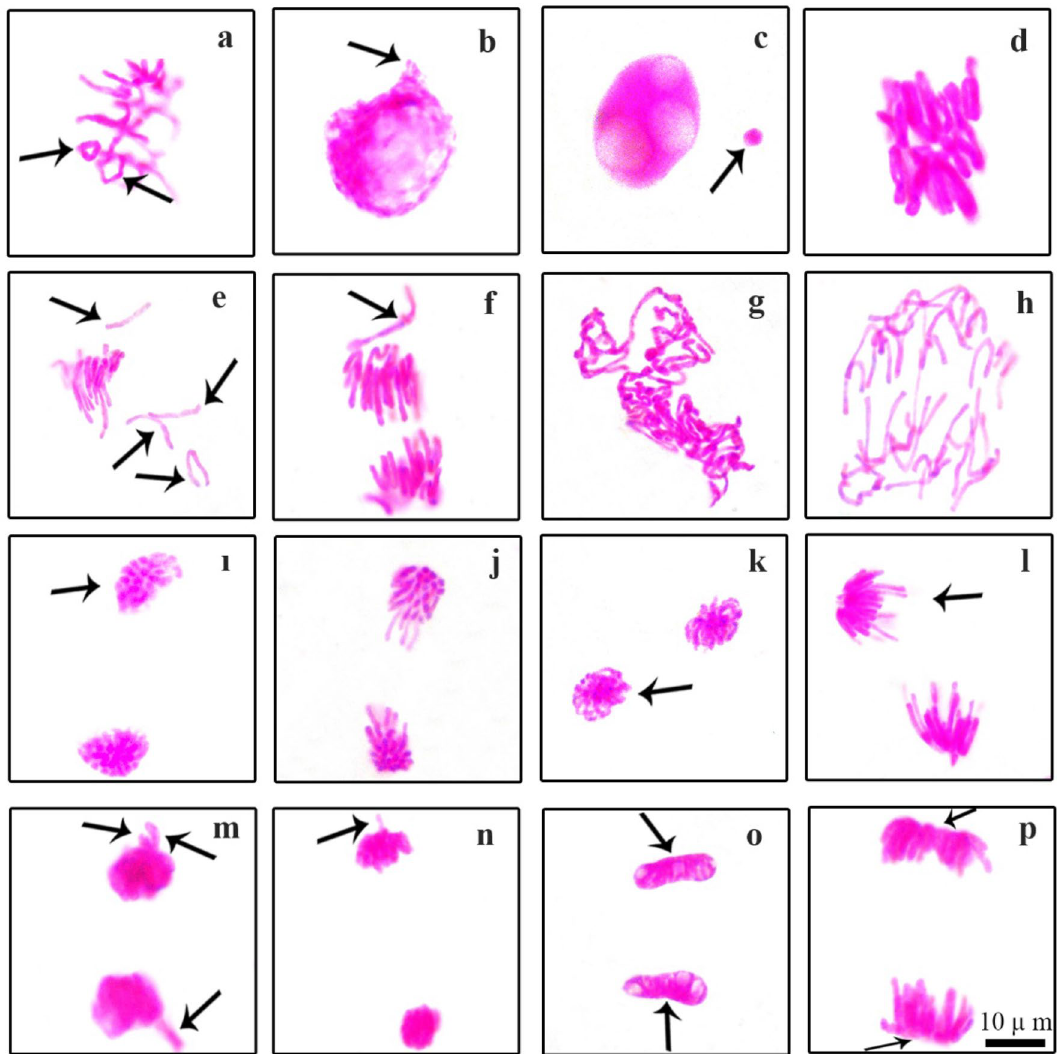
Figure 6. Chromosomal abnormalites in the root meristem cells of Allium cepa L. grown in 0.15 M NaCl and 0.01 µM COR + 0.15 M NaCl medium, ( a ) metaphase with chromosome encircleds = arrows, ( b ) nuclear budding = arrow, ( c ) trilobulated nucleus with micronucleus = arrow, ( d ) stickiness metaphase, ( e ) metaphase with chromosomal losses = arrows, ( f ) anaphase with chromosomal loss = arrow, ( g ) aberrant prophase, ( h ) aberrant anaphase, ( i ) anaphase with polar slip = arrow, ( j ) chained anaphase, ( k ) telophase with polar slip = arrow, ( l ) anaphase with polar slip = arrow, ( m ) telophase with vagrant chromosomes = arrows, ( n ) anaphase with vagrant chromosome = arrow, ( o ) alignment telophase = arrows, ( p ) alignment anaphase = arrows. Scale bar 10 IV according to that (24.6 ± 1.7) of Group II in 0.15 M salinity (Fig. 4). Xie et al. 63,65 determined that 0.01 µM exogenous COR application decreased MDA content in the root of cotton seedlings grown in 150 mM NaCl medium; and these results were agreement with findings of the this study. Haddadi et al . 117 reported that MDA content in tolerant genotypes to salt were lower than the sensitive genotypes. For this reason, the reduction of MDA content by COR in Group IV may be a sign that Allium cepa L. provides tolerance to salinity. Proline is one of the most widely produced osmolytes 132 , which plays an important role in maintaining osmotic potential and turgor in plants exposed to high salinity 133,134 . Moreover, proline also performs the task of protecting cells by stabilizing cellular membranes and proteins during dehydration 135–137 . Although this amino acid is synthesized in plants through glutamate and ornithine, the glutamate pathway is the main source of proline production under osmotic stress 114 . In this study, while the free proline content in the root of Group I (control) bulbs germinated in tap water medium was 15.1 ± 1.7, this parameter was measured as 16.3 ± 2.1 in the root of Group III bulbs germinated in medium containing COR alone, and these two values were statistically similar (Fig. 4). Ceylan et al. 66 detected that 0.01 µM COR application enhanced the proline content in roots of chickpea plants grown in stress-free conditions; and this conclusion was not consistent with the finding of current research. Whereas, NaCl triggered a drastic increase in the free proline level (54.5 ± 3.9) in the roots of Group II bulbs.